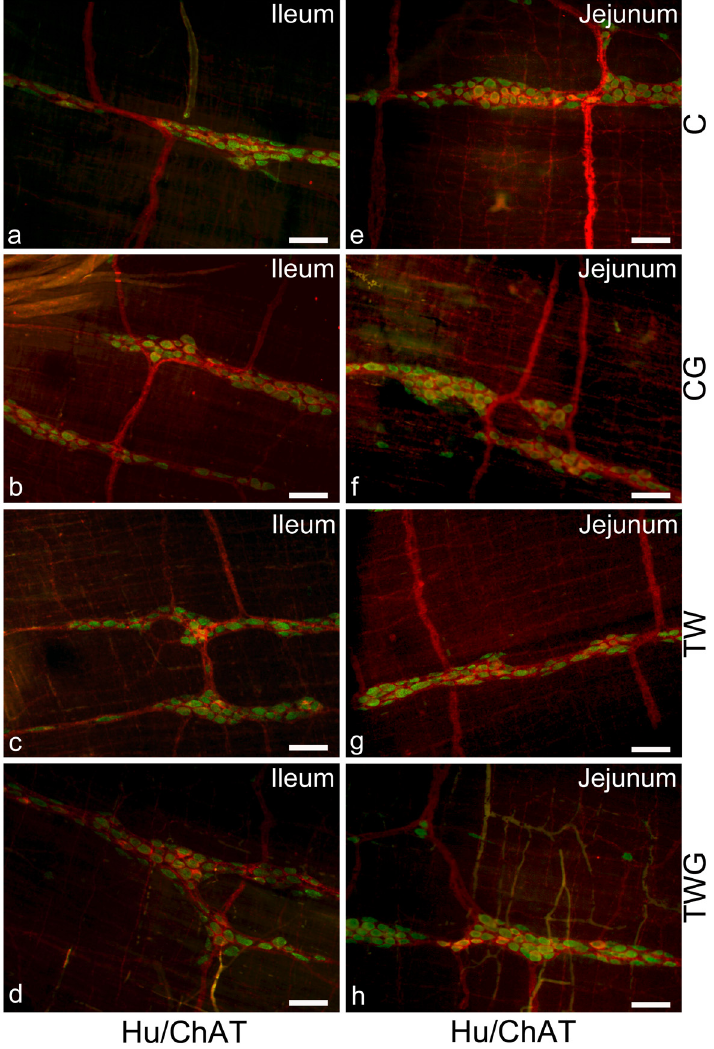
Fig 1. Representative images of Hu/CHAT myenteric neurons. Double immunostaining of HuC/D and CHAT myenteric neurons of ileum (a-d) and jejunum (e-h). Experimental groups: control (C); control supplemented with 2% L-glutamine (CG); Walker-256 tumor (TW); and Walker-256 tumor supplemented with 2% L-glutamine (TWG). These images are composites of merged images taken separately from red (CHAT) and green (HuC/D) fluorescent channels. Scale Bar 50 μ